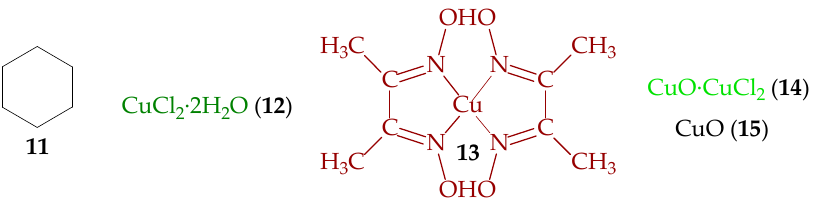
Scheme 2. Additional components of the catalytic system: hydrocarbon 11 and catalysts 12 – 15 .